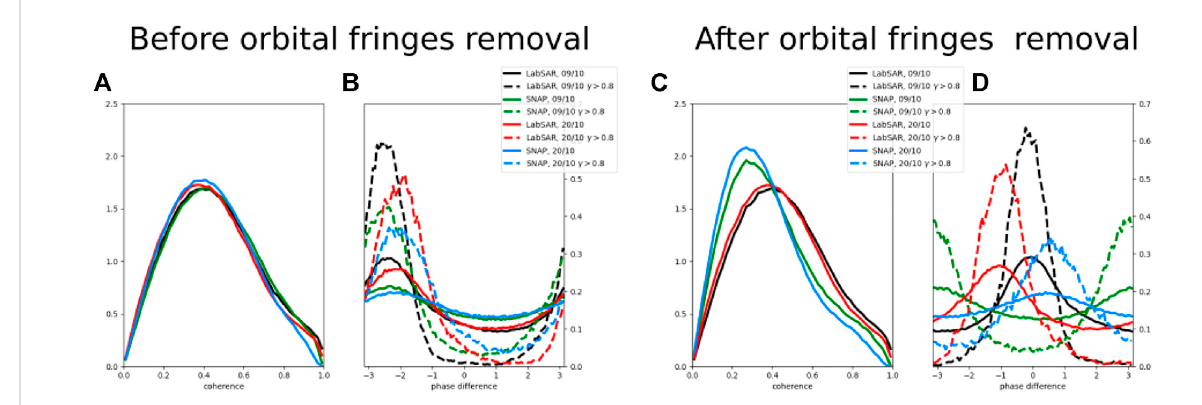
FIGURE 6 (A) Histograms of the coherence for the four interferograms after orbital fringes removal. (B) Histogram of the pixel-wise comparison of the measure phase and the reference phase obtained from the height of the area, with orbital fringe removal — the entire image − − pixel with a coherence above 0.8. (C) Histograms of the coherence for the four interferograms before orbital fringes removal. (D) Histogram of the pixel-wise comparison of the measure phase and the reference phase obtained from the height of the area, without orbital fringe removal — the entire image − − pixel with a coherence above 0.8. Interferogram between the 20/09/2020 image and 09/10/2020 coregistered with LabSAR, interferogram between the 20/09/2020 image and 20/10/2020 coregistered with LabSAR, interferogram between the 20/09/2020 image and 09/10/2020 coregistered with SNAP, and interferogram between the 20/09/2020 image and 20/10/2020 coregistered with SNAP.